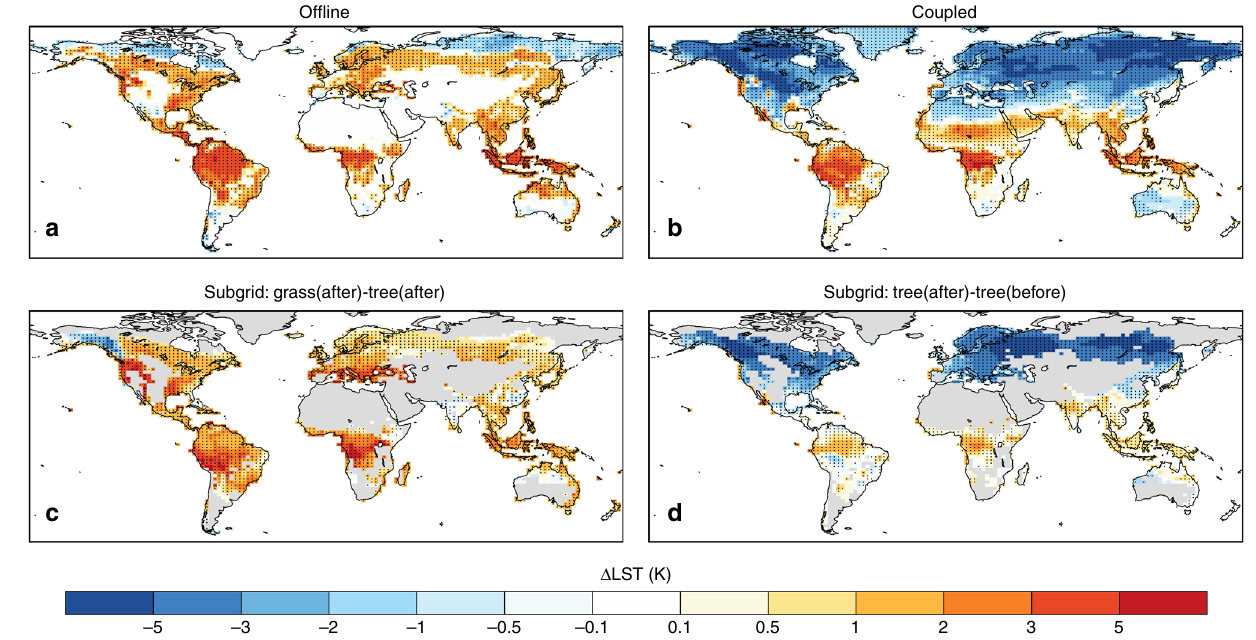
Fig. 2 Simulated impacts of deforestation on summer daily maximum land surface temperature. The land surface temperature (LST) difference is calculated based on the Community Earth System Model (CESM) a low-res of fl ine, b low-res coupled, and ( c , d ) subgrid deforestation experiments. In c the local impacts are de fi ned as the LST difference between the grass and tree tiles in the postdeforestation (after) simulation; in d the nonlocal impacts de fi ned as the LST difference for the tree tiles between the postdeforestation (after) and predeforestation (before) simulations. Stippling indicates the temperature difference is signi fi cant at a false discovery rate (FDR) adjusted p values of